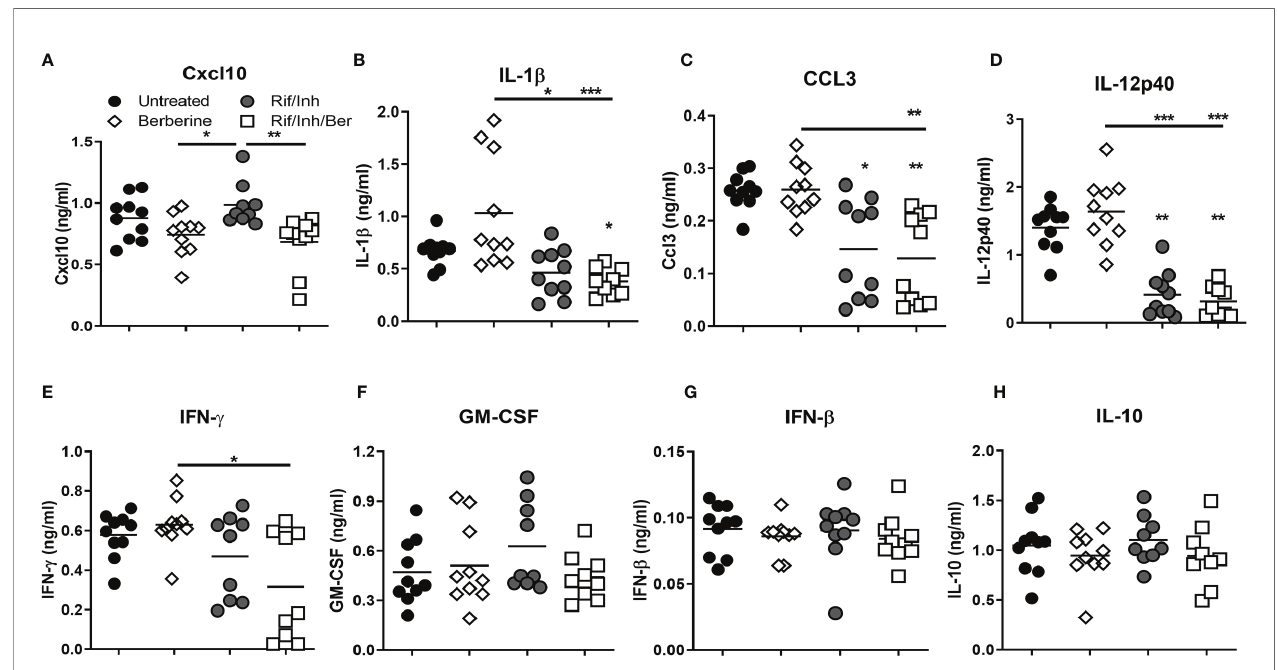
FIGURE 5 | Effect of berberine on lung cytokines as an adjunctive therapy during Mtb infection in C57BL/6 mice. Lung homogenates were analyzed for the cytokines and chemokine by ELISA at 5 weeks post-infection; (A) CXCL10, (B) IL-1 b , (C) CCL3, (D) IL-12p40, (E) IFN g , (F) GM-CSF, (G) IFN- b and (H) IL-10. Data is shown from pooled two experiments (n = 10 per group) and the line denotes mean value, analysed by Kruskal-Wallis test with Dunn ’ s multiple comparisons correction de fi ning differences in all groups as signi fi cant *P ≤ 0.05; **P ≤ 0.01; ***P ≤ 0.001. Asterisks without the line below show the signi fi cance compared to the untreated group.